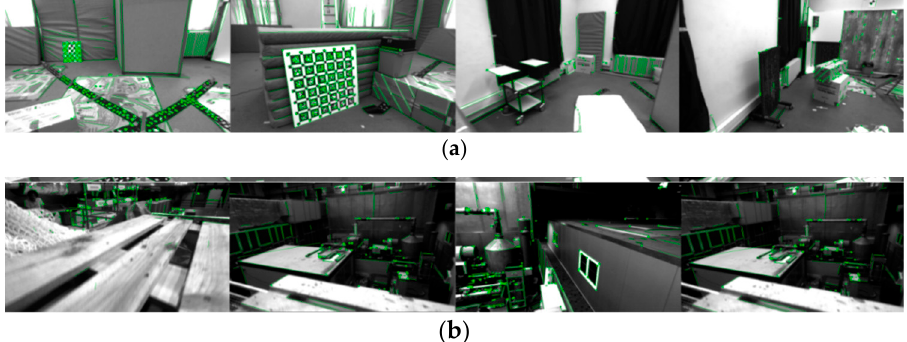
Figure 6. Feature extraction performances of the VIO front-end: ( a ) V1_01_easy sequence; ( b ) MH_04_difficult sequence.